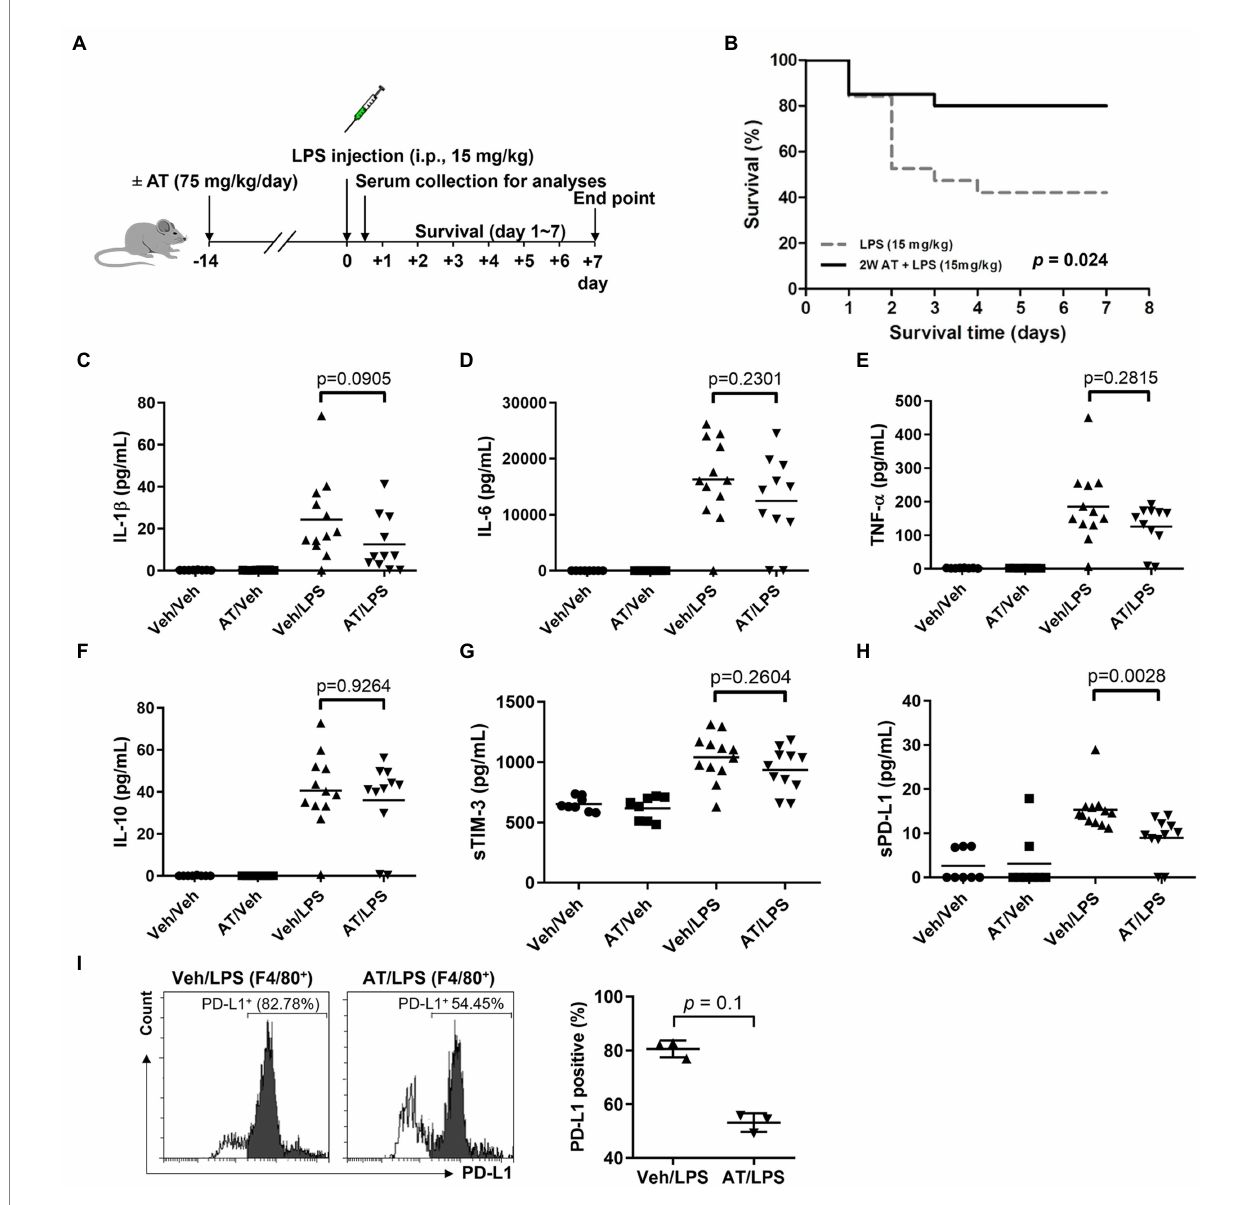
FIGURE 1 Effects of atenolol treatment on LPS-induced septic mice. (A) Schematic representation of experimental design. Two groups of C57BL/6 mice were injected with LPS (15 mg/kg) after 2 weeks of feeding with or without atenolol (75 mg/kg/day). (B) The Kaplan–Meier survival rate of LPS-induced septic mice with or without atenolol treatment. The mice were observed until day 7. (C–I) After feeding with or without atenolol for 2 weeks, C57BL/6 mice were injected with or without LPS (15 mg/kg). Samples were collected 12 h after vehicle or LPS injection. (C–H) Effects of atenolol treatment on the release of pro-inflammatory cytokines and soluble biomarkers in serum of LPS-induced septic mice. IL-1 β , IL-6, TNF- α , IL-10, sTIM-3 and sPD-L1 were measured and analyzed by the ProcartaPlex multiplex assay. (I) The percentage of F4/80 positive macrophages expressing surface PD-L1 in BALF of LPS-induced septic mice. AT: atenolol, Veh: